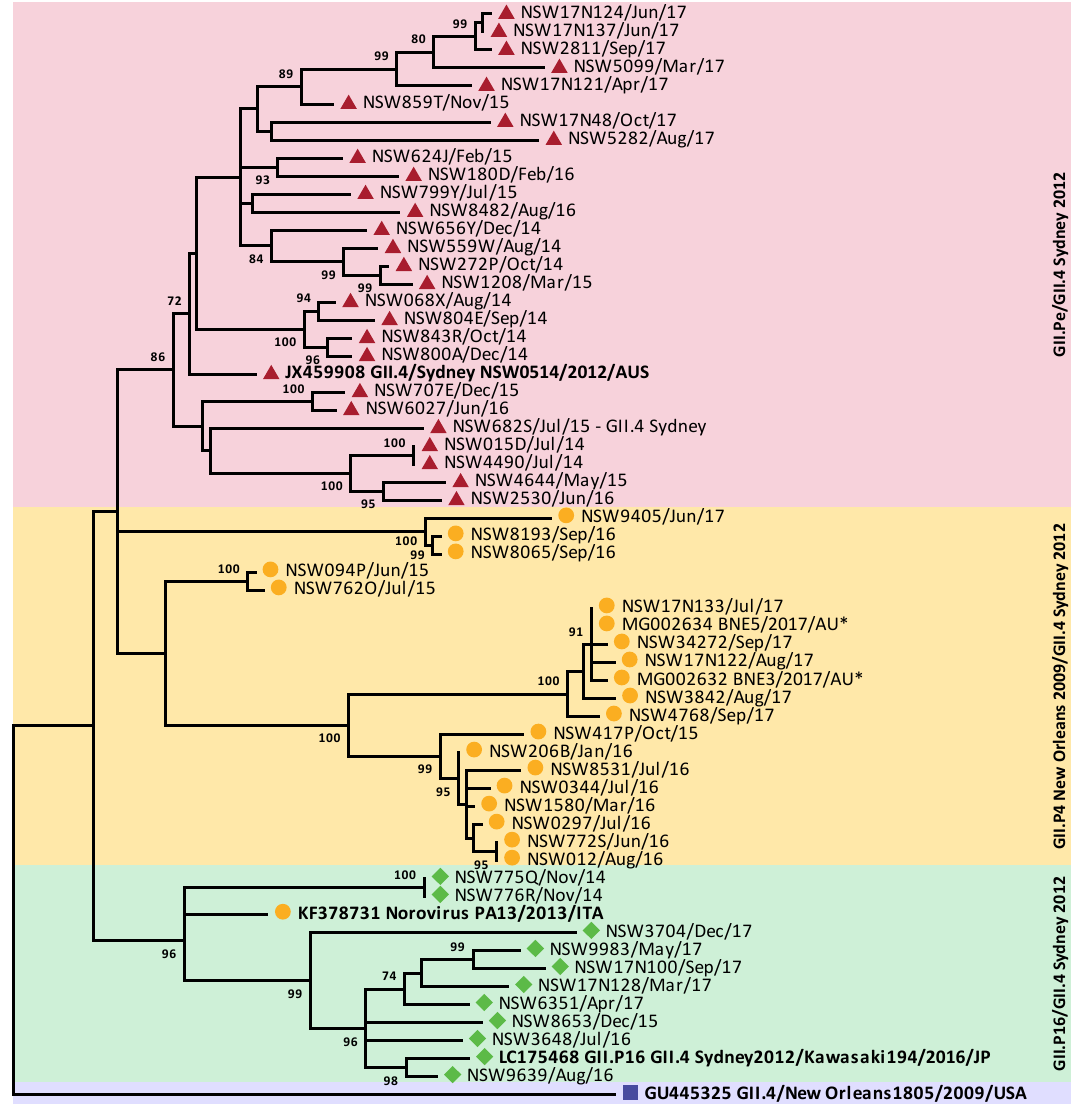
Figure 5. Phylogenetic analysis of GII.4 full length capsid sequences. Representative full-length GII.4 capsid sequences were selected between 2013 to 2017 and compared to prototype GII.4 pandemic variants and GII.4 recombinant viruses. Sample sequences are denoted by the sample location, sample ID and date of collection. Prototype sequences of each GII.4 pandemic variant and GII.4 recombinant viruses are indicated in bold. Reference sequences were obtained from GenBank, labelled with its accession number and country of isolation. The GII.Pe/GII.4 Sydney 2012 sequences are denoted with a red triangle, GII.P4 New Orleans 2009/GII.4 Sydney 2012 with a yellow circle, the GII.P16/GII.4 Sydney 2012 sequences with a green diamond and the prototype GII.4 New Orleans 2009 is denoted by a purple square. The asterisks (*) denote sequences obtained from the Bruggink et al. 2018 study [34]. Sequence alignments were performed with MUSCLE algorithm. Maximum likelihood phylogenetic trees were produced using MEGA 5 software with bootstrapping test of 1000 replicates, based on the Kimura 2-parameter model. The bootstrap percentage values are shown at each branch point for values ≥ 70%. The scale bar indicates the number of substitutions per